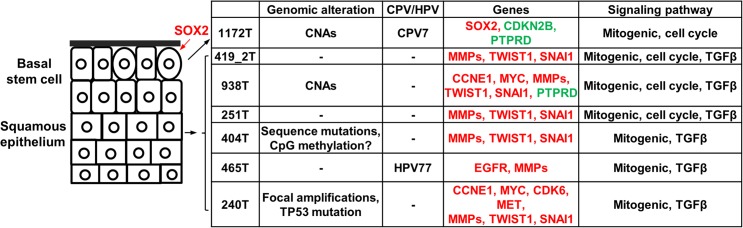
The proposed carcinogenic mechanisms of canine oSCCs investigated.The cells of origin in these tumors are hypothesized as indicated, with oval cells representing the basal stem cells. Alterations at various levels are shown. For individual gene alterations, red represents gene amplification or overexpression, while green represents gene deletion or underexpression.